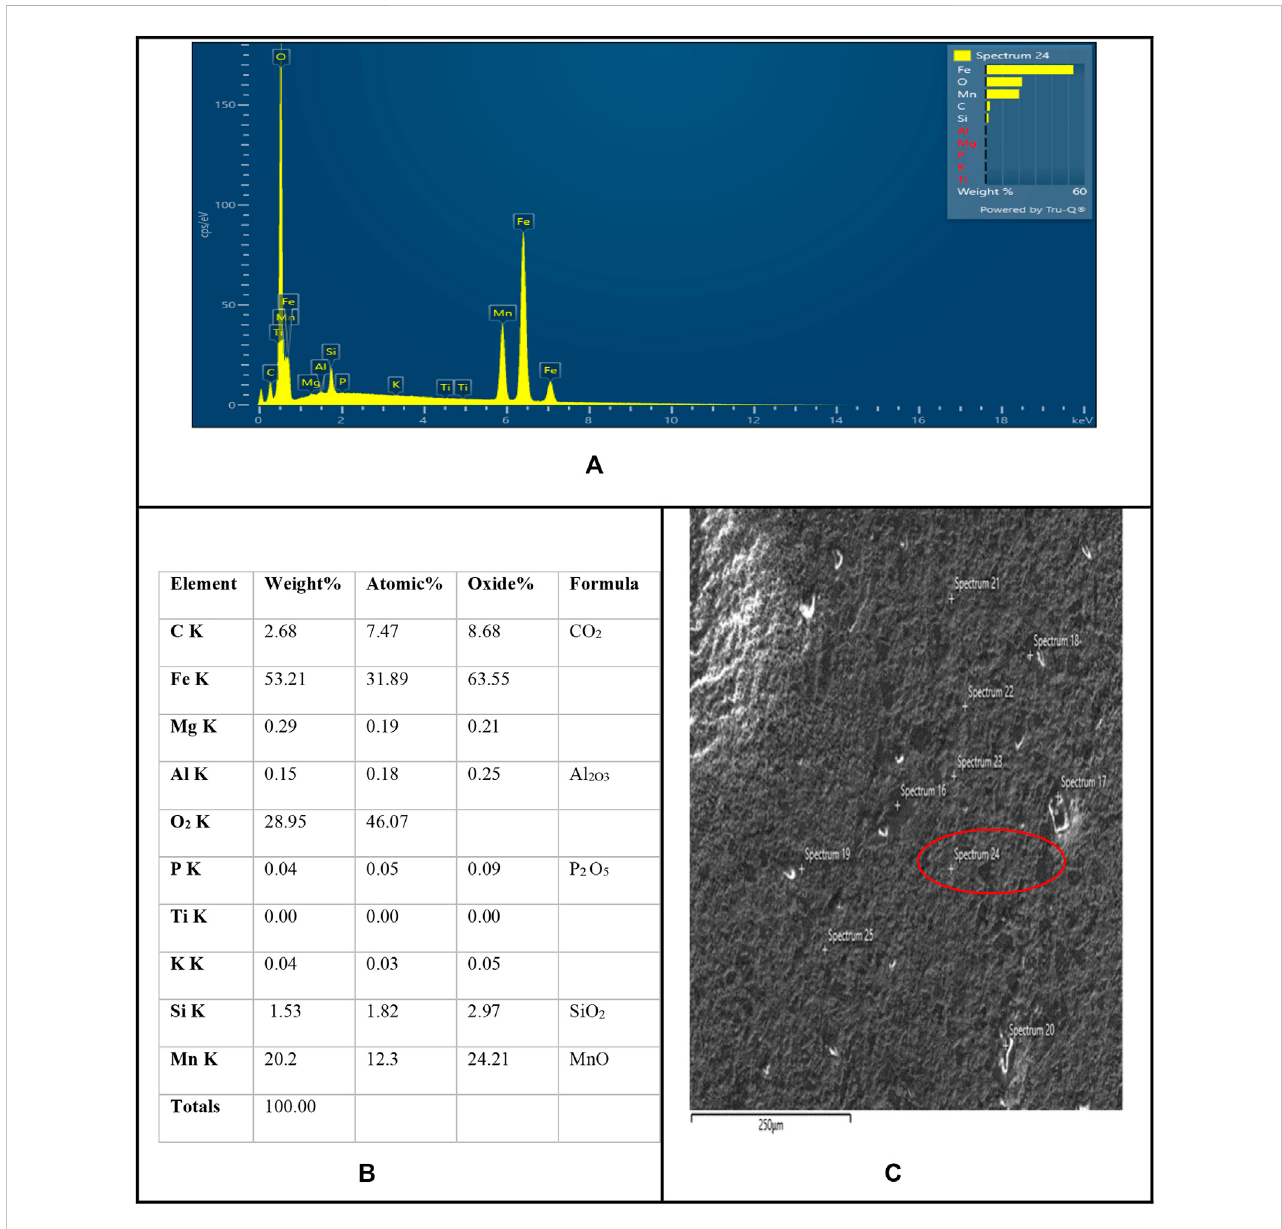
FIGURE 4 Distribution of elements after heat treatment at 700 ° C with Energy Dispersive System Analysis of X-rays using SEM. (A) . Energy dispersive X-ray (EDX) spectra of sample, (B) Table EDS analysis of inclusions from Figure (C) , (C) Complex inclusions in the sample of non-oriented electrical steel sheet containing %